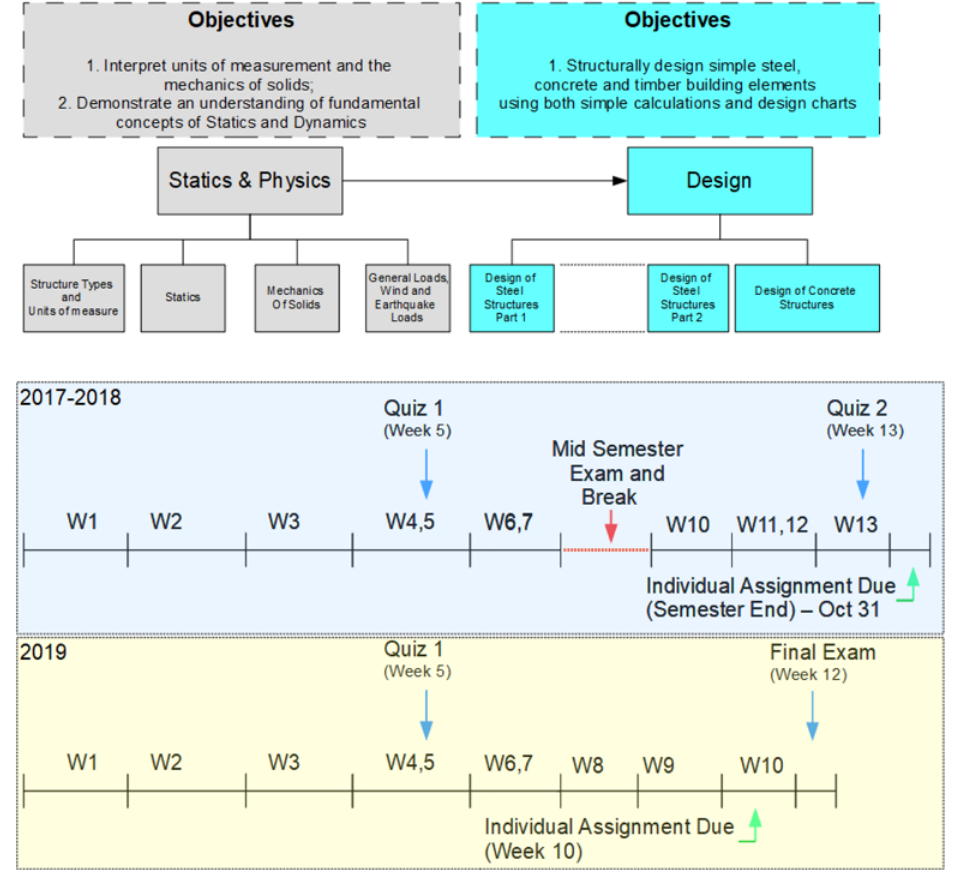
The selected case details including course objectives, contents, and weekly distribution, note: W refers to